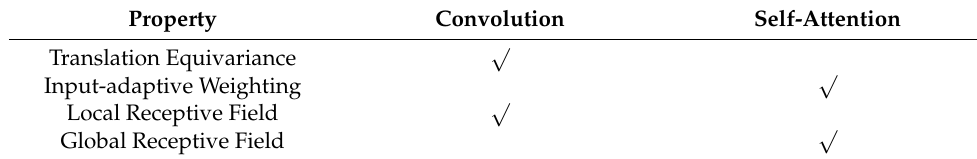
Table 1. The properties of the convolution and the self-attention.